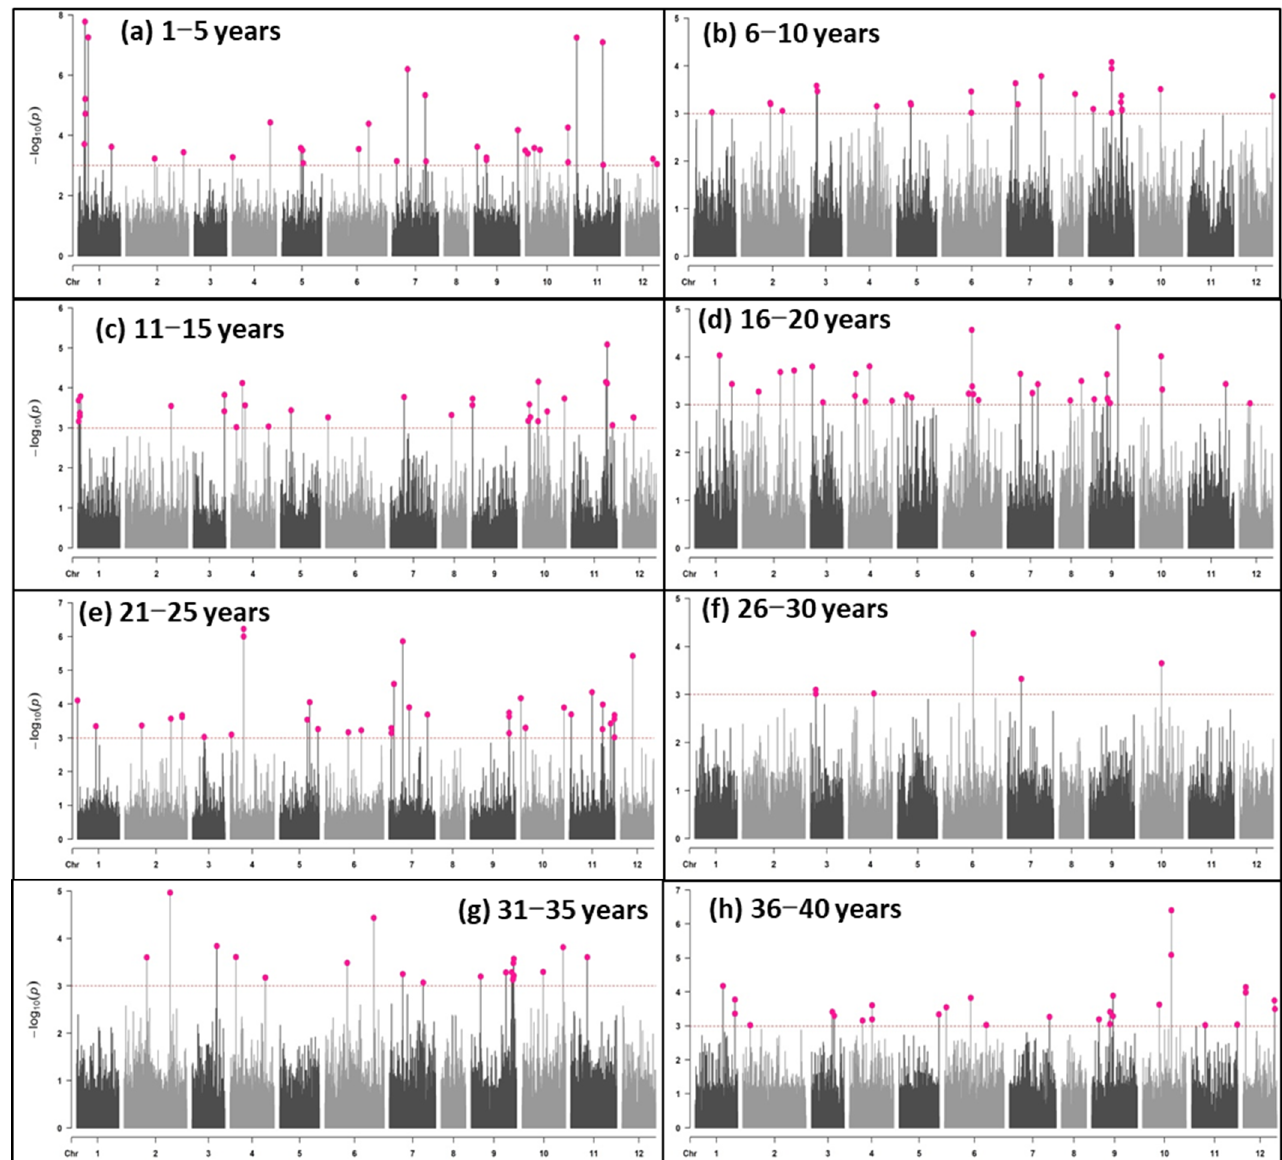
Figure 2. The plot of a genome-wide scan (GWA analysis) of SNP markers associated with seed longevity over various periods of storage (( a ) after 1–5 years of storage, ( b ) after 6–10 years of storage, ( c ) after 11–15 years of storage, ( d ) after 16–20 years of storage, ( e ) after 21–25 years of storage, ( f ) after 26–30 years of storage, ( g ) after 31–35 years of storage and ( h ) after 6–10 years of storage) in Capsicum accessions. The chromosomes are shown on the x -axis, the genome-wide scan −log10 ( p values) is shown on the y -axis, and the significantly associated SNPs are highlighted in pink.